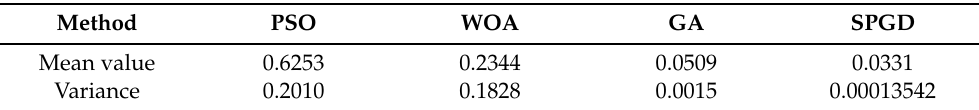
Figure 10. Comparison of relative error of different methods in 10 experiments when µ = 0.1. Table 3. The mean values and variances of relative error in 10 experiments in different methods when µ = 0.1.